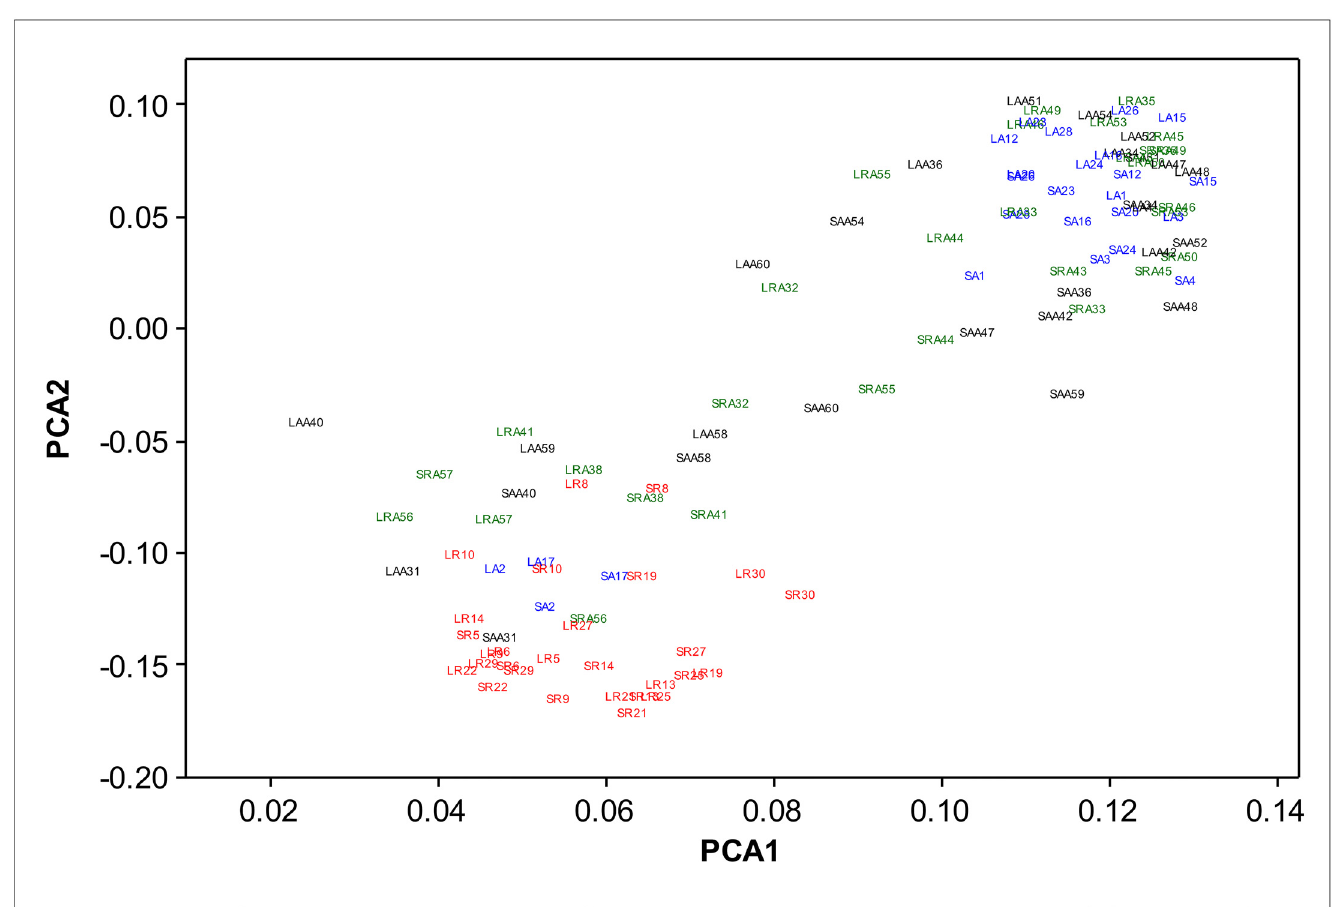
Fig 2. Principal components analysis (PCA) of relative abundances. PCA was used to compare variation of relative OTU abundances within and between liquid (L) and solid (S) rumen samples from groups R, A, RA and AA. Variation in individual samples is shown. Red = group R (LR and SR), blue = group A (LA and SA), green = group RA (LRA and SRA) and black = group AA (LAA and SAA). Individual animals are indicated by numbers (e.g. LRA55 and SRA55 are animal number 55, liquid and solid respectively, treatment group